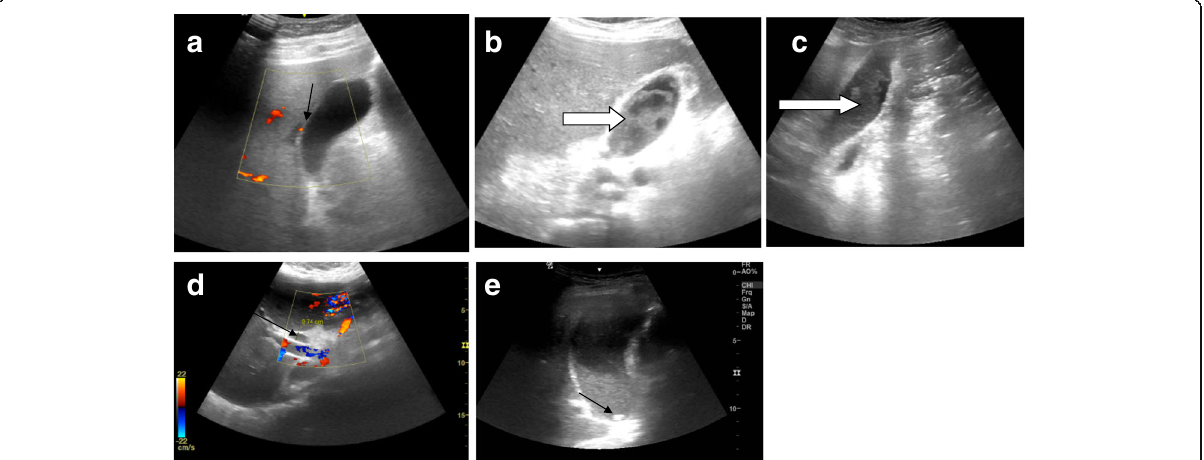
Fig. 1 Biliary system disease in five different COVID-19 intensive care patients: ( a ) the gall bladder shows thickened edematous wall with subtle mural hyperemia (arrow) ( b ) and ( c ) marked intraluminal biliary mud (arrows) sequel to cholestasis ( d ) ectatic CBD (7.4 mm) (black arrow) with no definite obstructive lesions probably due to cholestasis ( e ) distended gall bladder with mud, a subcentimeter gall bladder stone is noted (black arrow)